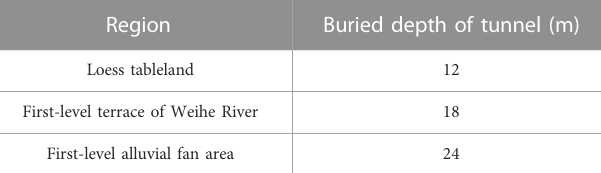
TABLE 1 Calculation conditions. Region Buried depth of tunnel (m)